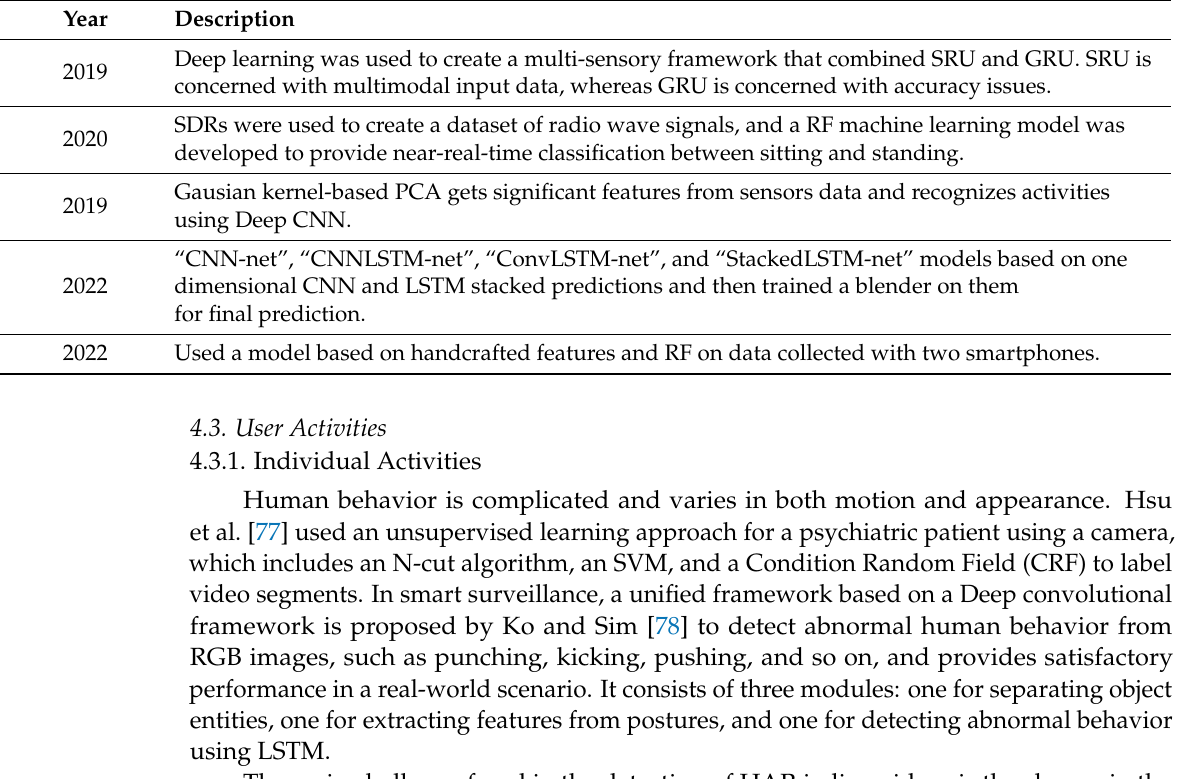
Table 5. Summary of literature on